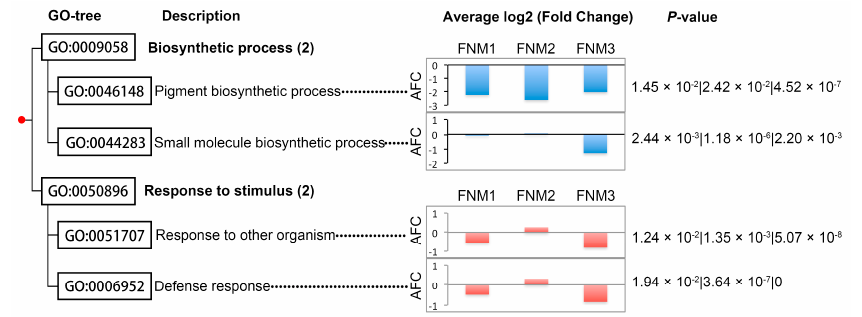
Table 4. Differentially expressed genes (DEGs) in FL vs. SL ovules at three free nuclear mitosis (FNM) stages in FG